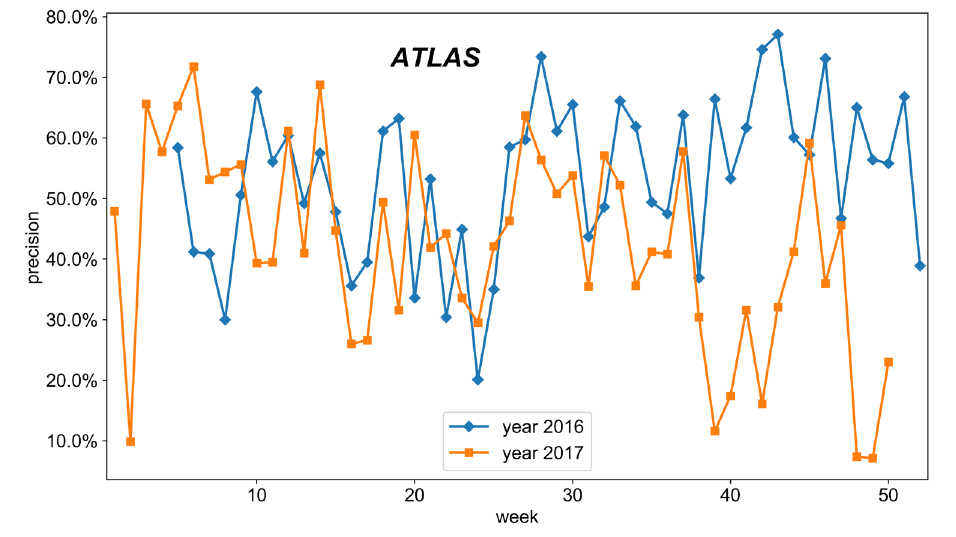
Figure 5. Precision of the popularity prediction for weeks in 2016 and